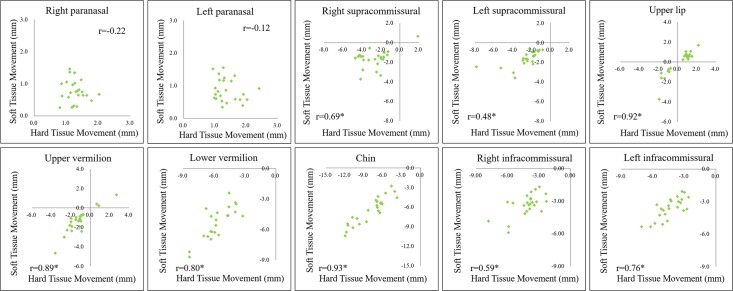
Scatter plots of the soft tissue average movements with respect to underlying hard tissue average movements for 10 regions; r denotes the correlation coefficient for each plot.